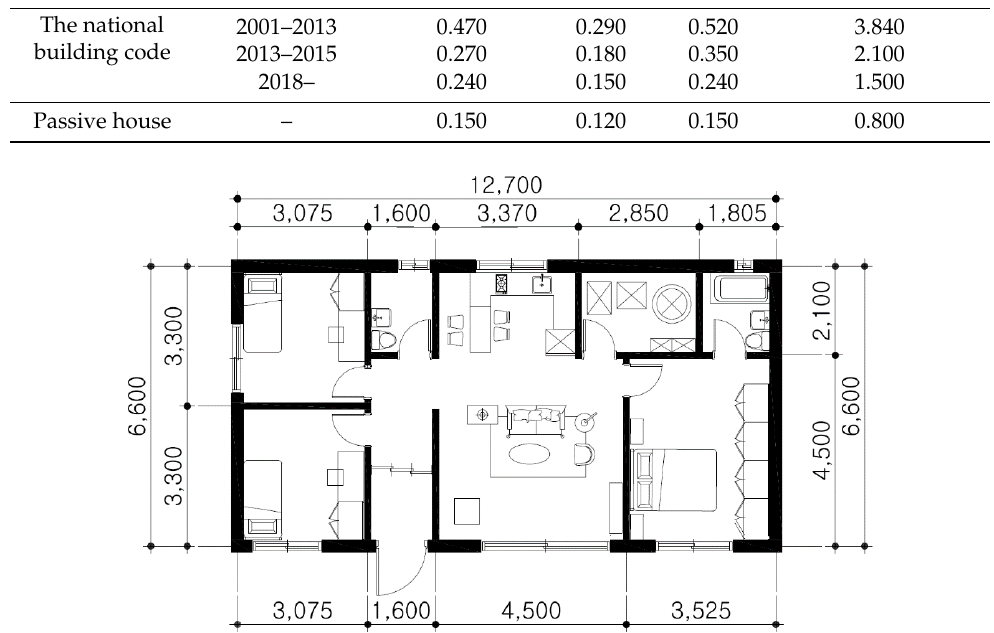
Figure 1. Plan of the simulation model. Table 2. Weather conditions.